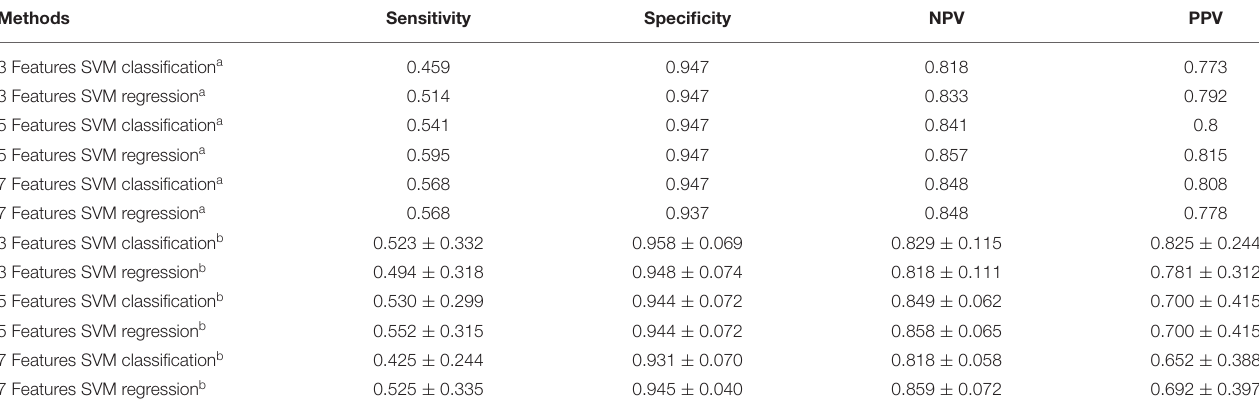
TABLE 2 | Performance of SVM.